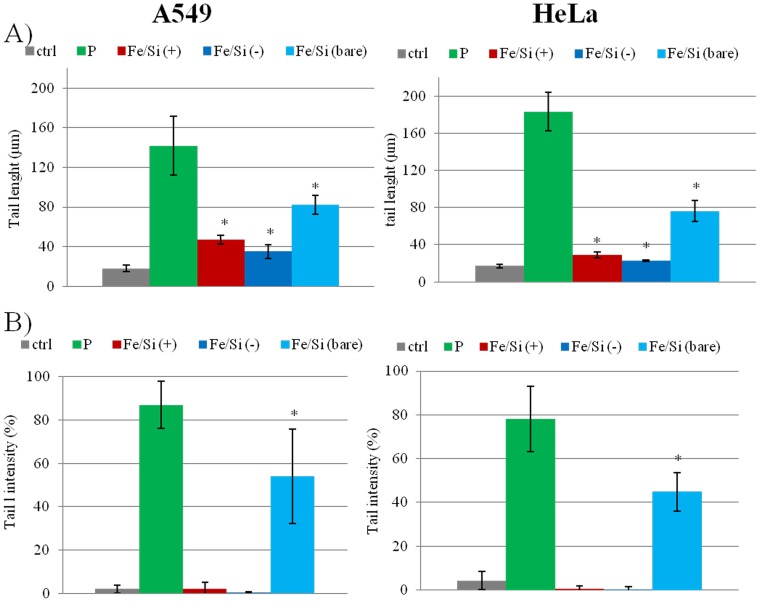
Effect of bare and passivated Fe3O4/SiO2 NPs on DNA damage.A549 and HeLa cells were treated with 2.5 nM of NPs for 48 h. DNA damage was evaluated through the comet assay by A) tail length and B) tail DNA intensity. Values shown are mean from 100 randomly selected comet images of each sample. As a positive control (P) cells were incubated with 500 µM H2O2. Data are reported as mean ± SD from three independent experiments; *P < 0.05 compared with control (n =  3).